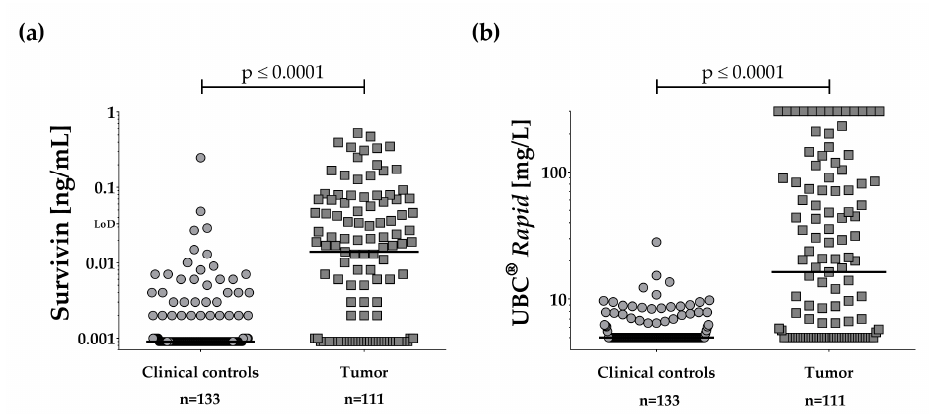
Figure 2. Dot plots of marker results in urine. Comparison of marker concentrations in urinary samples from clinical controls and bladder tumor patients. ( a ) Survivin and ( b ) UBC ® Rapid . Lines depict the median for each group. p -Values were obtained from the Wilcoxon signed-rank test.